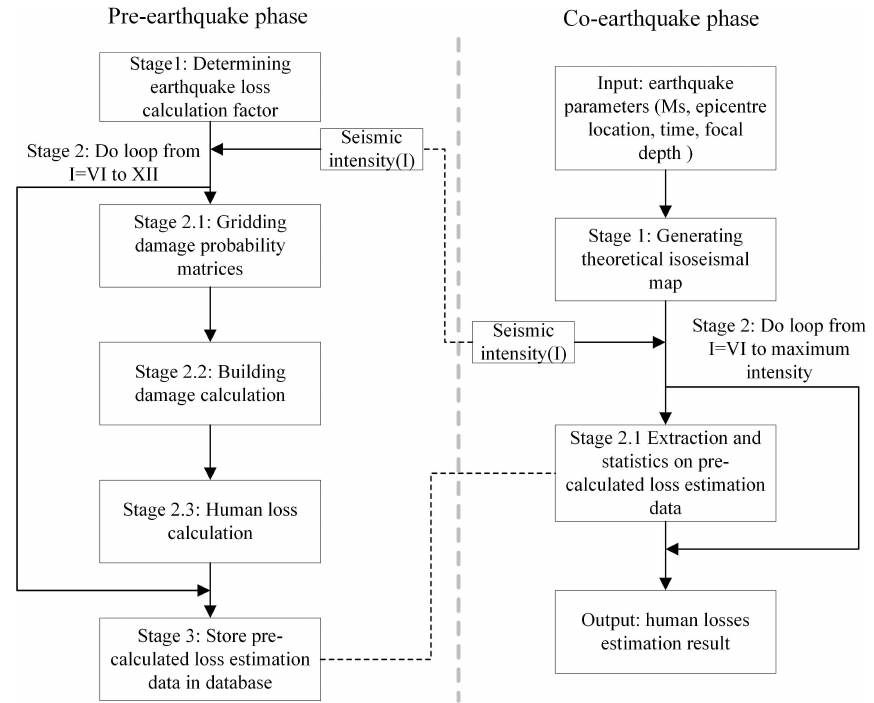
Figure 2. Components and workflow of the two-phase earthquake disaster loss estimation